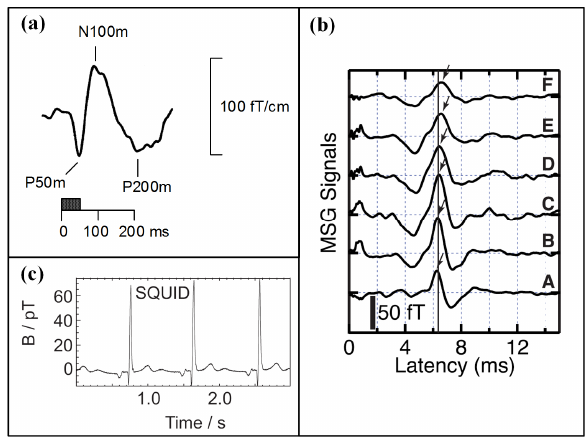
Figure 4. ( a ) Typical MEG response evoked by a 50 ‐ ms tone [44]; ( b ) Waveforms of the z ‐